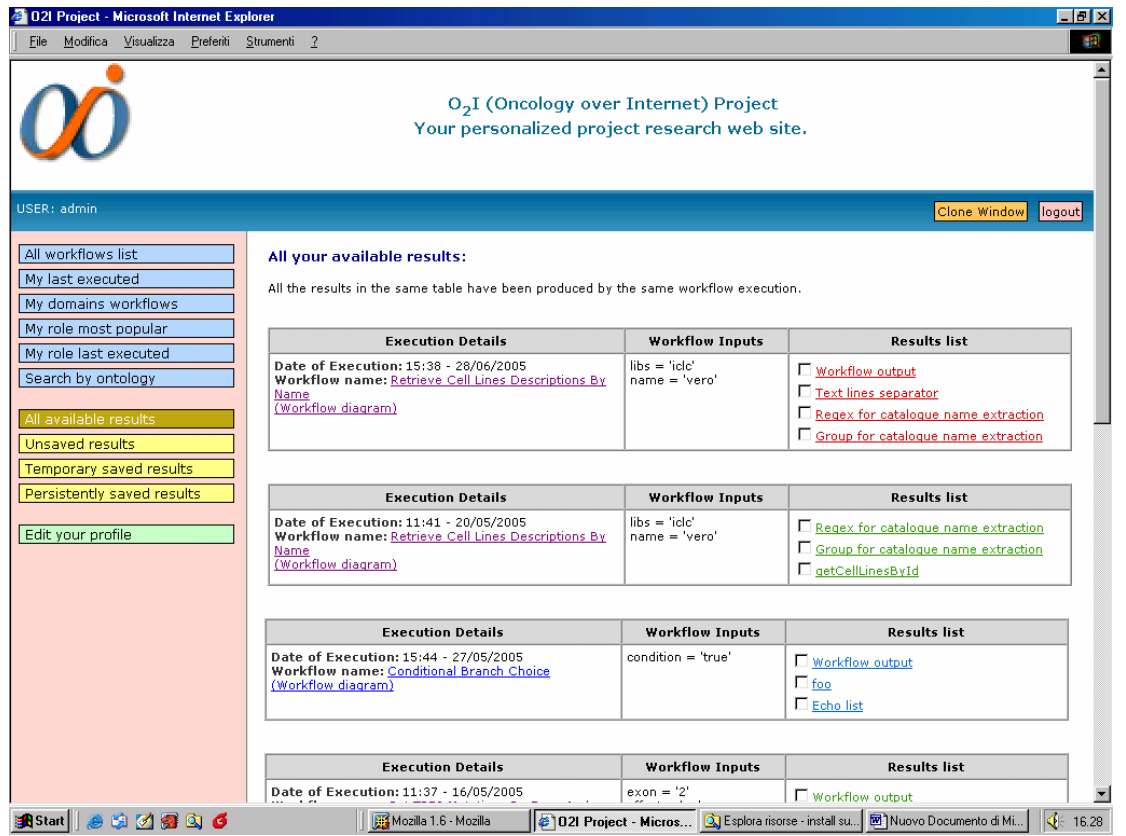
Figure 5: web page allowing for the examination of saved